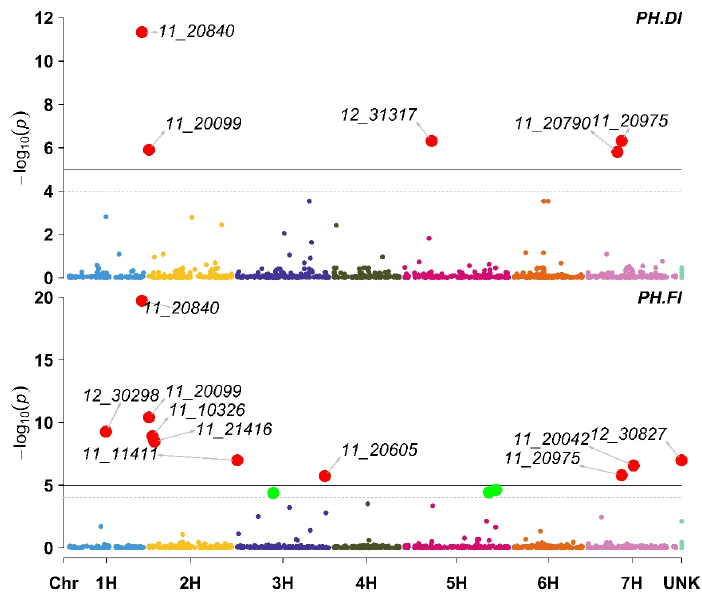
Figure 5. Manhattan plot displaying the results of the genome-wide association scan (red dots annotated dots refer to significant markers or markers with −log10 (p) more than 5, while the green dots refer to non-significant markers but have −log10 (p) between 4 and 5) for the plant height (PH) using 426 barley lines under Deficit Irrigation (PH.DI, upper plot) and Full Irrigation (PH.FI, lower plot).